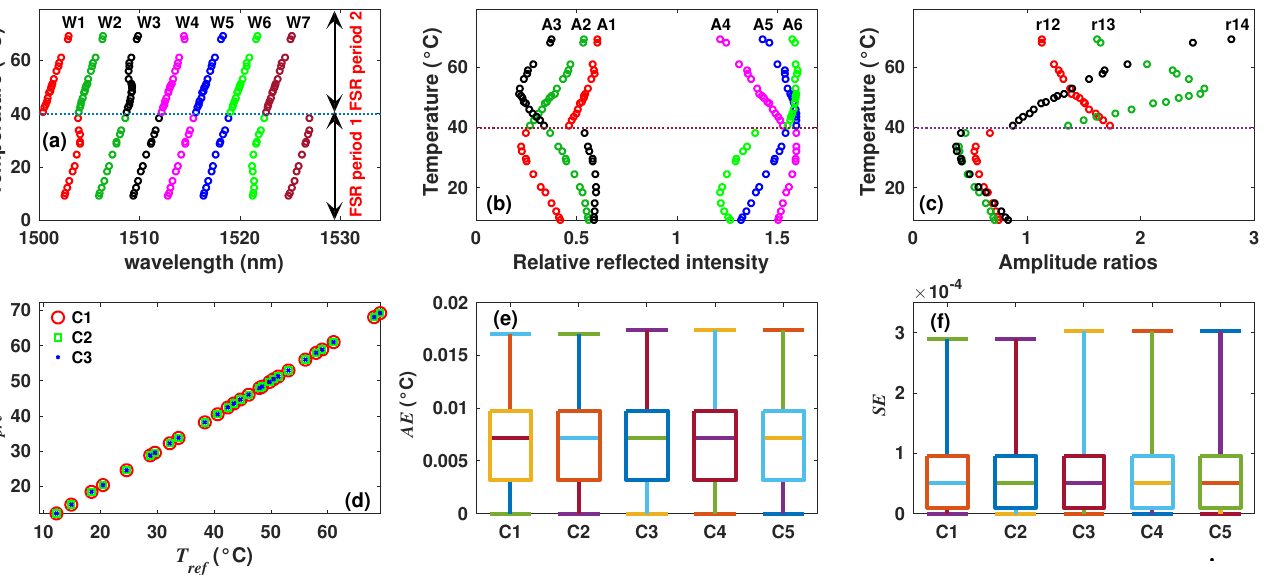
Figure 9. Measured ( a ) peak wavelength positions, ( b ) peak amplitudes, ( c ) amplitudes ratio r 12 as a function of temperature of sensor 1. In ( b ), A5–A7 were shifted 1 unit to the right for clarity purposes; ( d ) comparison between T est and T ref ; ( e ) AE and ( f ) SE distributions for T est obtained considering different input combinations